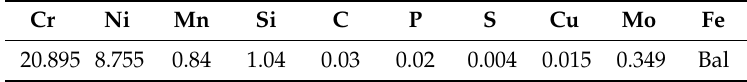
Table 1. Chemical composition of the tested Z3CN20-09M cast duplex stainless steel (wt.